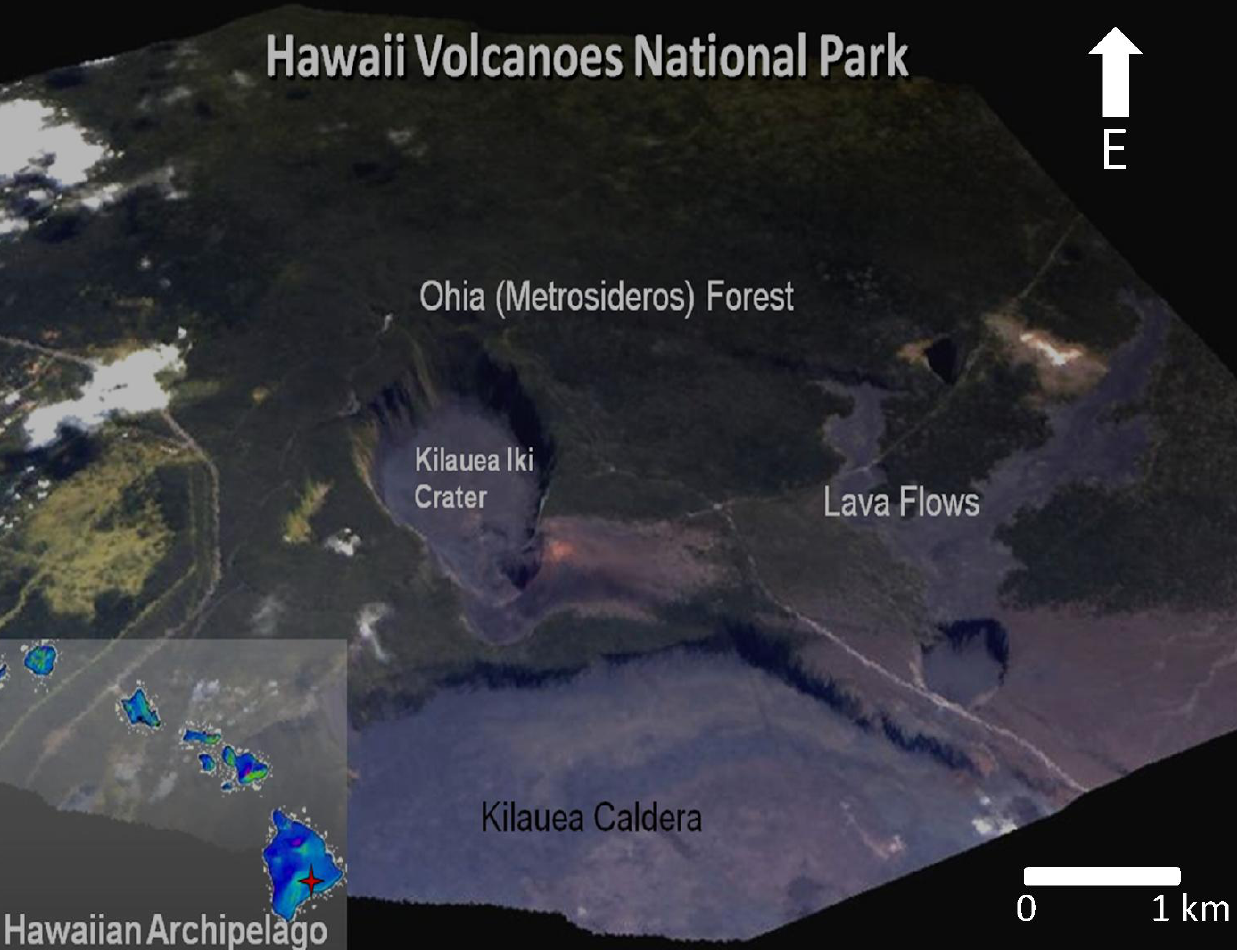
Figure 1. Overview of the Hawai’i Volcanoes National Park on the Island of Hawai’i (19.4°N, 155.2°W; imagery from the Carnegie Airborne Observatory;